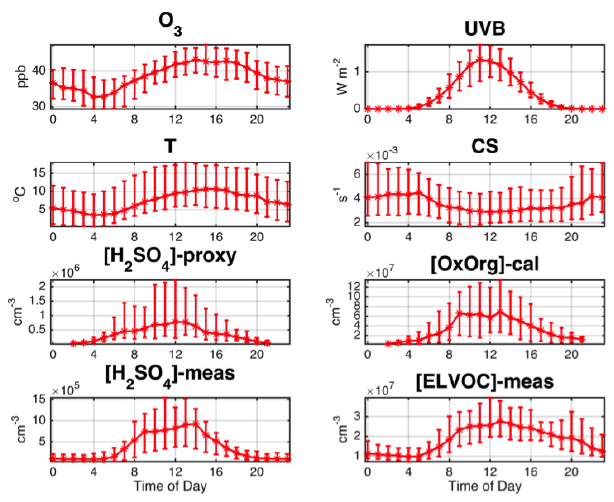
Figure 3. Diurnal variation of O 3 , UV-B, temperature, condensation sink (CS) and calculated sulfuric acid proxy and oxidation organics from monoterpene according to Nieminen et al. (2014) as well as the measured sulfuric acid and ELVOCs concentration in gas phase.